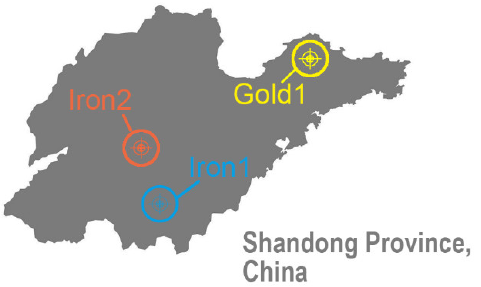
Figure 1. Sources of the tailings used in this study.